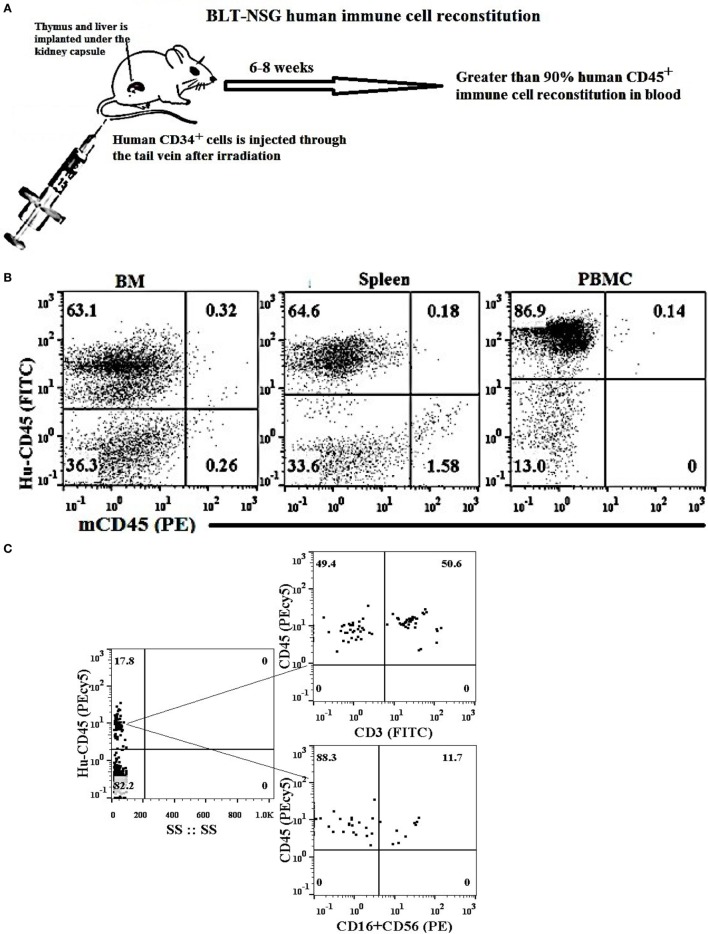
Tail vein injection of super-charged NK cells with and without feeding with AJ2 reversed inhibition of IFN-γ and IL-8 secretion by the gingival cells of tumor-bearing BLT mice. Humanized-BLT (hu-BLT) mice were generated as shown in the figure (A). Reconstitution of human immune cells in blood, BM and spleen of hu-BLT mice was analyzed using human and mouse CD45 antibodies. Percentages of each of human and mouse CD45+ immune cells are shown in each respective quadrant (B). Gingival tissues were harvested from each group of mice and single-cell suspensions were prepared. Surface expression of human CD45, CD3, CD16, and CD56 were determined using flow cytometric analysis after staining with respective PE- and FITC-conjugated antibodies. Isotype control antibodies were used as control. One of three representative experiments is shown in the figure (C). Flow chart presents the experimental design using hu-BLT mice. Mice were orthotopically implanted with 1 × 106 of human oral or pancreatic tumor cells in the floor of the mouth or in the pancreas. One to two weeks after tumor implantation selected hu-BLT mice received 1.5 × 106 human or hu-BLT mice super-charged NK cells via tail vein injection. Mice were fed with AJ2 (5 billion/dose) two weeks before the tumor implantation and continued throughout the experimental period every 48 h (D). Four to five weeks after tumor implantation mice were sacrificed and gingival cells from tumor-bearing mice injected with NK cells and fed with and without AJ2 probiotic bacteria were dissociated and single-cell suspensions were prepared and treated with IL-2 (1,000 units/ml) and the levels of IFN-γ (n = 4) were determined in supernatants harvested after 7 days of culture using specific ELISAs (E). The fold increase in IFN-γ secretion from the gingival cells of each mouse groups namely, control, NK injected in tumor-bearing mice or NK injected in tumor-bearing mice and fed with AJ2 was calculated based on the amounts released from cells obtained from tumor-bearing mice only (F). To demonstrate that autologous NK cells show the same profiles of activation as the allogeneic NK cells among groups of mice, single-cell suspensions of gingival cells from tumor-bearing hu-BLT mice injected with autologous super-charged NK cells and fed with and without AJ2 probiotic bacteria were treated with IL-2 (1,000 units/ml) and the levels of IFN-γ (n = 2) from the supernatants were determined after 7 days of culture using specific ELISAs (G). Single-cell suspensions of gingival cells from tumor-bearing mice injected with NK cells and fed with and without AJ2 probiotic bacteria were treated with IL-2 (1,000 units/ml) and the levels of IL-8 (n = 4) in the supernatants were determined after 7 days of cultures using multiplex array kit (H). Pancreatic tumors from tumor-bearing hu-BLT mice injected with NK cells with and without feeding with AJ2 were excised at the end of the experiment and tumor weights were determined (n = 3) (I). Gingival cells from oral tumor-bearing mice injected with NK cells and fed with and without AJ2 were treated with IL-2 (1,000 units/ml) and the levels of IFN-γ (n = 2) were determined in supernatants after 7 days of culture using specific ELISAs (J).